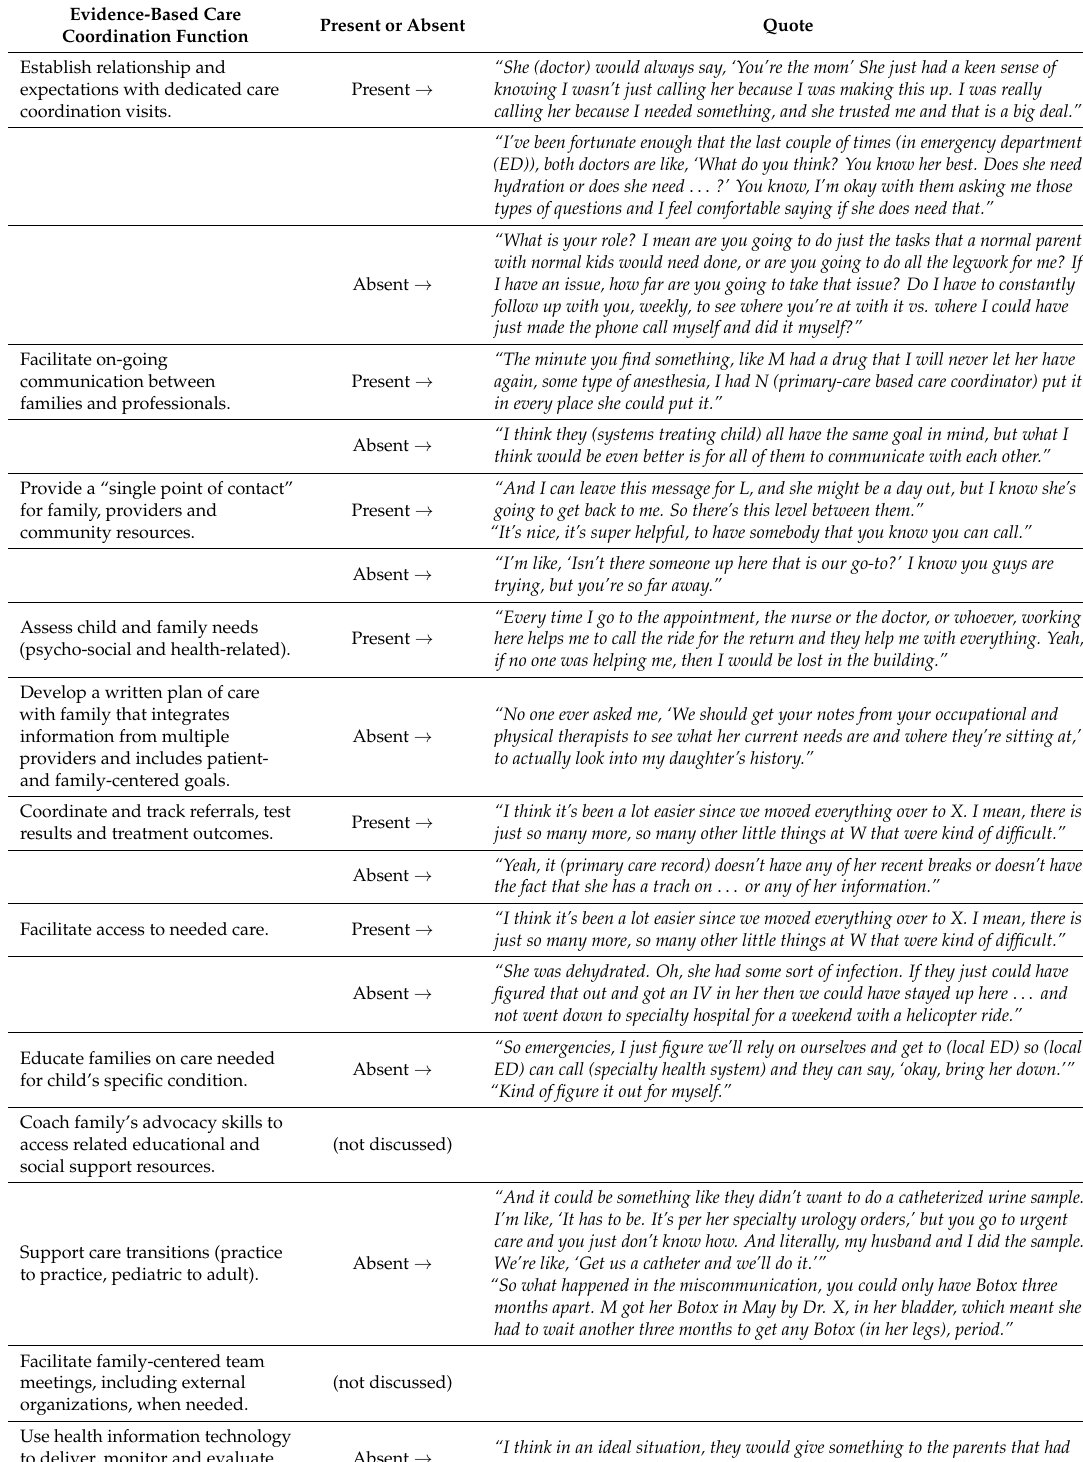
Table A1. Parental perception of the presence of evidence-based care coordination